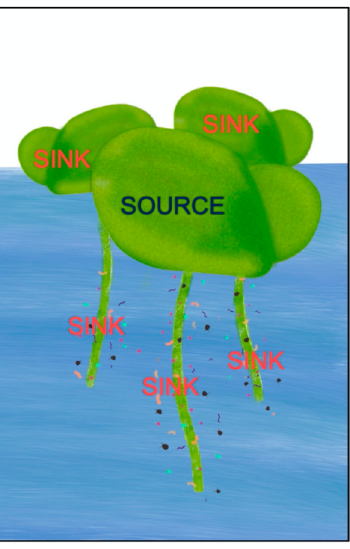
Figure 10. Schematic depiction of the effect of microorganisms in counteracting feedback inhibition of photosynthesis by (i) acting as a sink for carbohydrates, (ii) improving plant nitrogen content in support of new growth (as well as photosynthetic capacity), and (iii) indirectly and directly promot- ing safe electron outlets in chloroplasts and elsewhere.